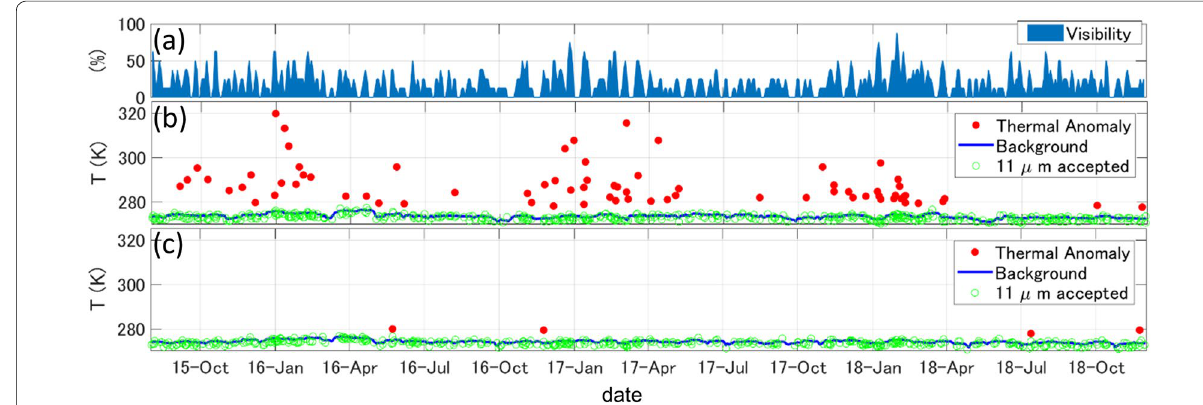
Fig. 4 a The visibility of thermal anomaly (ThVis) at NRV. b , c The accepted data points from the 11‑μm band (open green circles) and the values from the 3.9‑μm band showing significant thermal anomalies (red circles) at NRV ( b ) and NTV ( c ). The analysis was made from August 1, 2015, to November 30, 2018. The upper red arrows in b mark the three periods (P1, P2, P3) of high thermal anomalies at